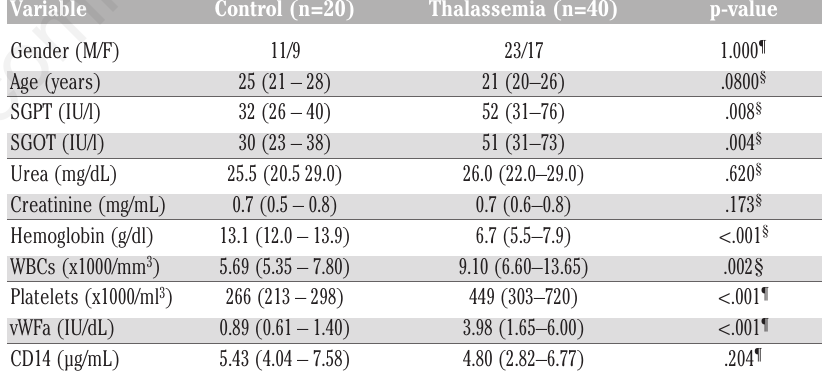
Table 2. Comparison between studied thalassemia patients and healthy control.